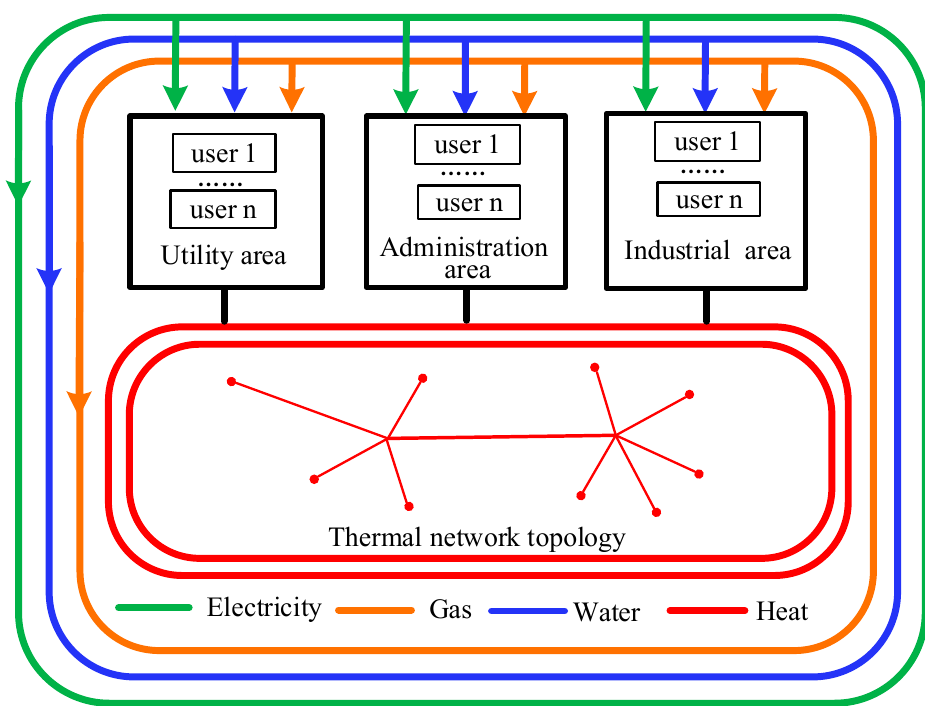
Figure 1. Multi-regional integrated energy system structure diagram.